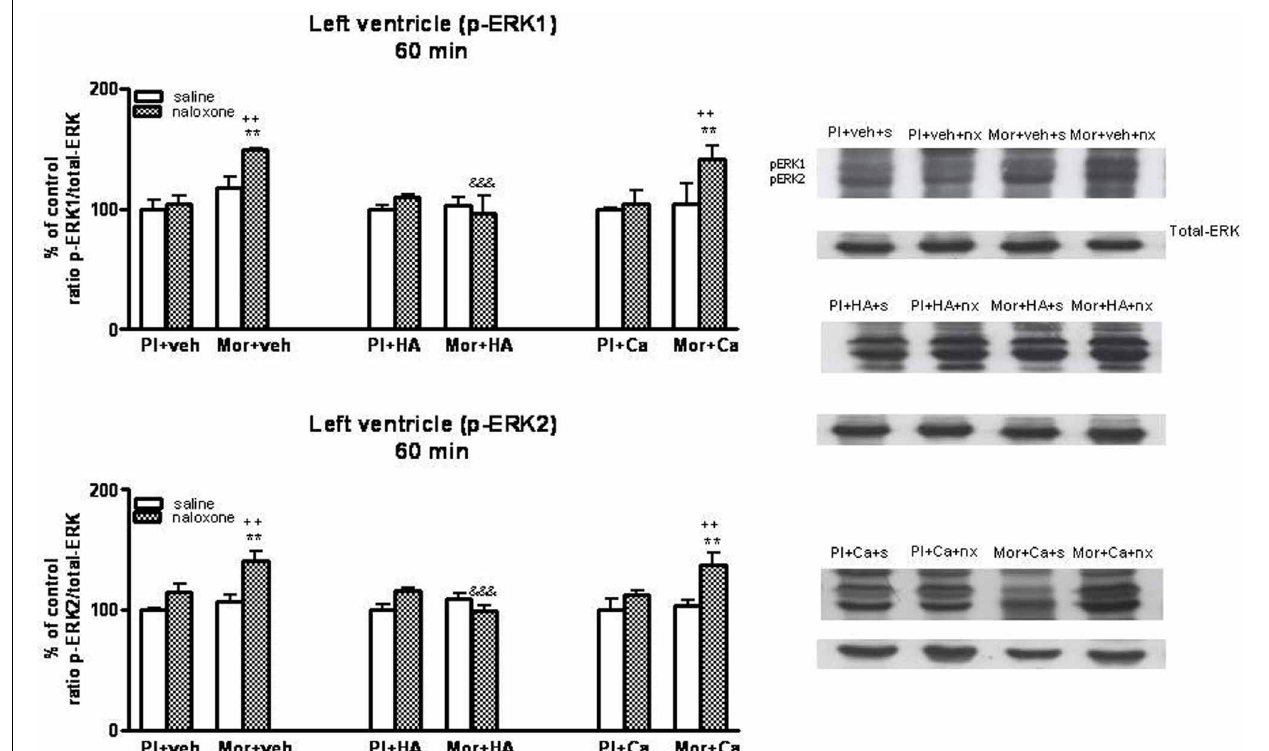
FIGURE 4 | Western blotting analysis of phospho (p)-ERK1 and phospho (p)-ERK2 immunoreactivity levels in the left ventricle 60min after saline (s) or naloxone (nx) administration to placebo (Pl)- or morphine (Mor)-treated rats receiving vehicle (veh), HA1004 (HA) or calphostin (Ca). The immunoreactivity corresponding to ERK1 or ERK2 is expressed as a percentage respect to the control group (Pl + veh + saline; defined as 100%